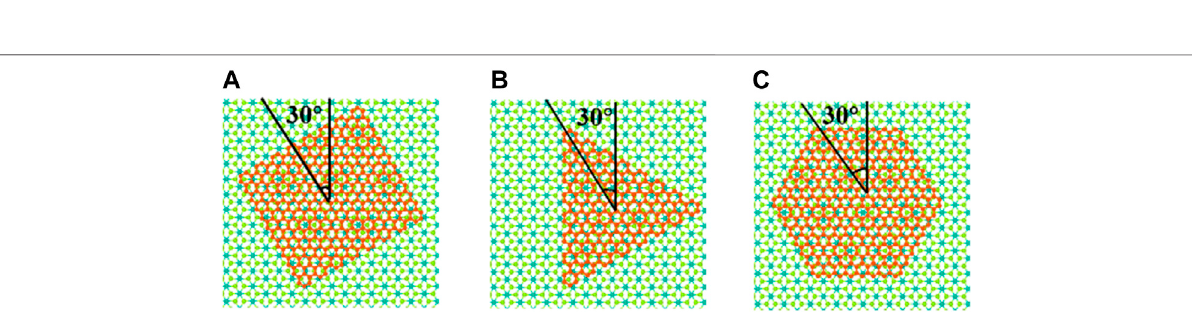
FIGURE2 | The atomic model diagram of theheterostructure composed ofdifferentshapes: (A) rectangle, (B) triangleand (C) hexagon stacked on thesubstrate.